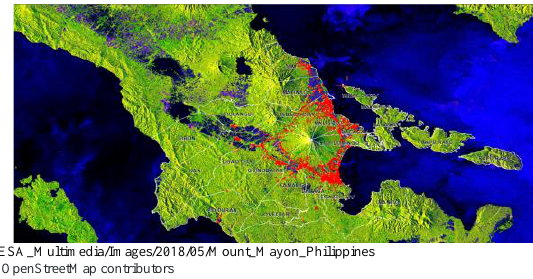
Figure 4 . OSM Building Footprints